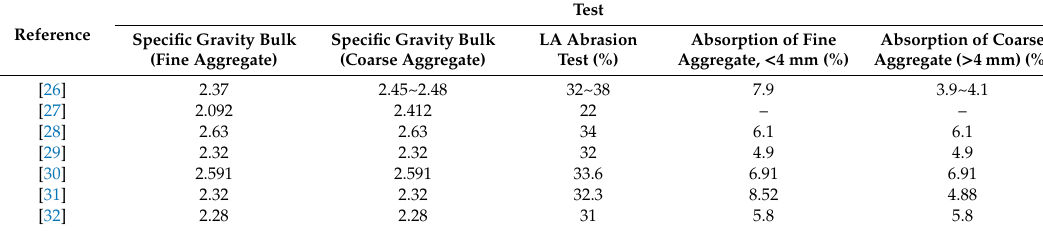
Table 1. Summary of the literature review on the results of RCA physical properties tests.